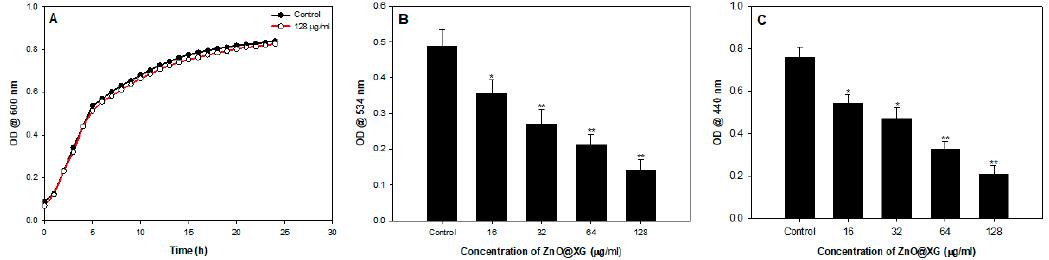
Figure 8. E ff ect of sub-MICs of ZnO@XG on ( A ) growth ( B ) prodigiosin production and ( C ) protease production in S. marcescens ATCC 13880. * denotes significance at p ≤ 0.05, and ** denotes significance at p ≤